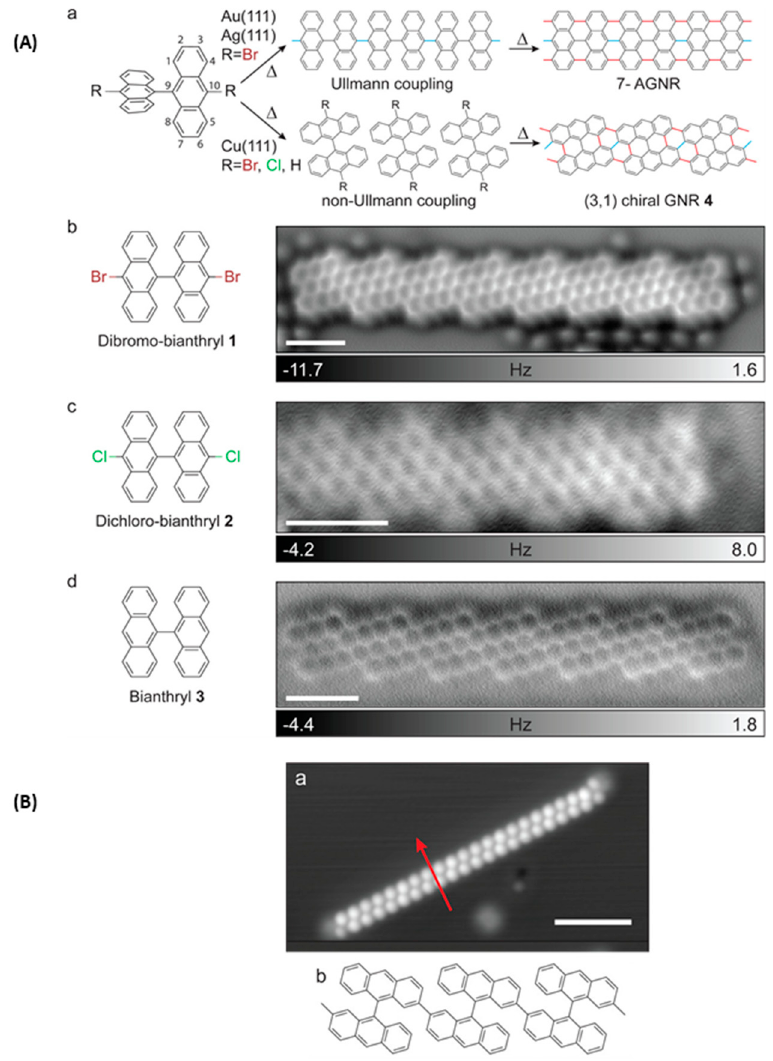
Figure 21. ( A ) GNRs obtained with different bianthracene (BA) precursors. ( B ) Connection of bianthracene precursors at the C2 and C2’ positions (scale bar: 1 nm for all noncontact AFM images). Adapted with permission from Schulz et al. [121]. Copyright 2017 American Chemical Society.